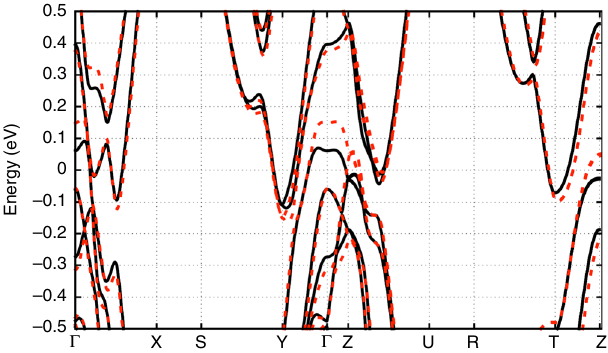
Fig. 6 DFT results. Calculated band structure of T d -MoTe 2 at ambient p (solid black curves) and for p = 1.3 GPa (dashed red